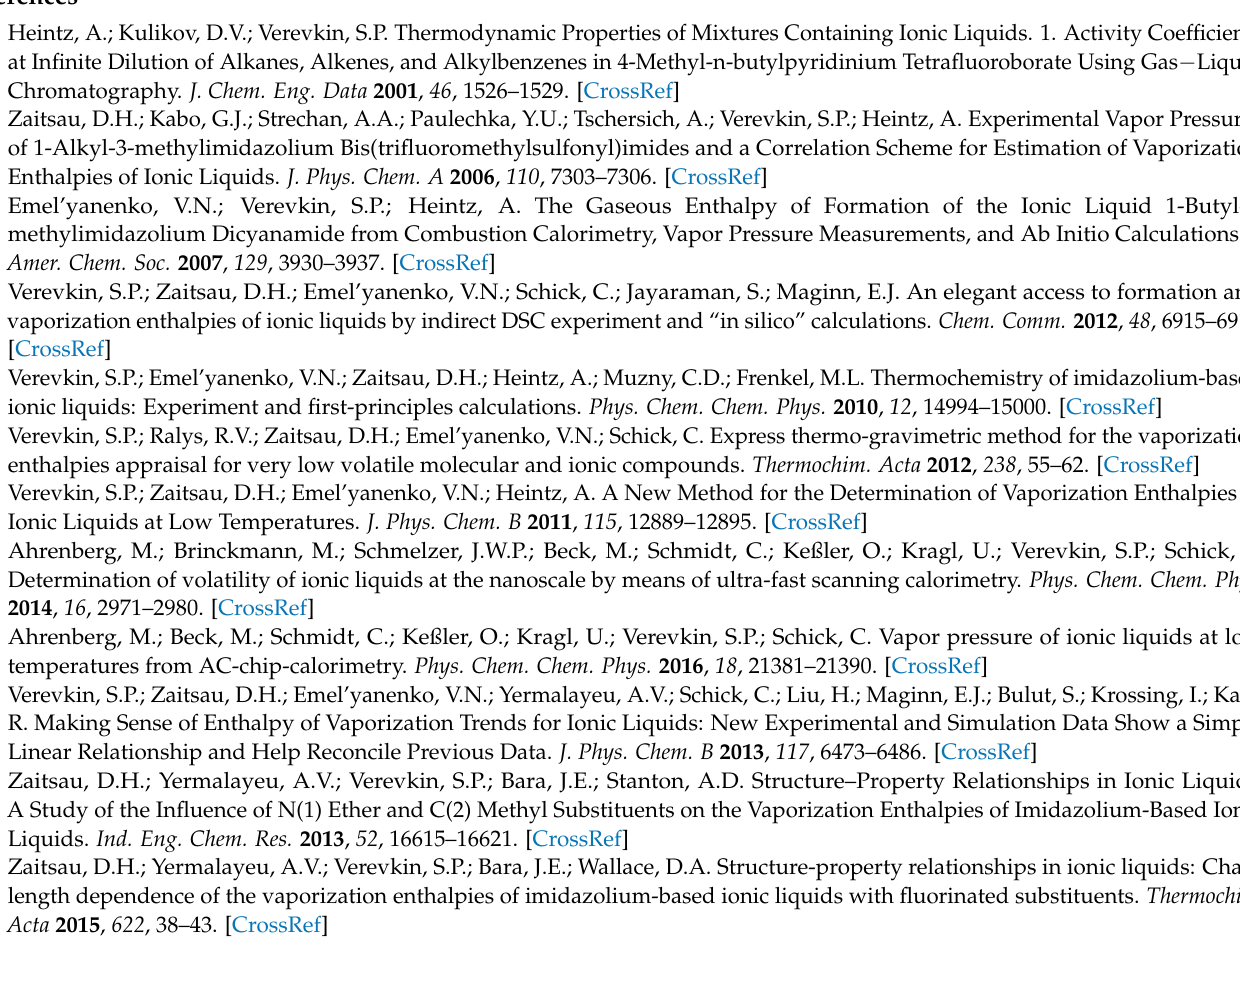
thalpies derived from activity coefficients with experimental results from conventional methods for [C n mim][NTf 2 ] series. Table S3: Comparison of vaporization enthalpies derived from activity coefficients with experimental results from conventional methods for [C n mim][NTf 2 ] series. Table S4: Comparison of vaporization en- thalpies derived from activity coefficients with experimental results from conventional methods for [C n mim][CF 3 CO 2 ] series. Table S5: Comparison of vaporization enthalpies derived from activity coefficients with experimental results from conventional methods for [C n mim][Anion] series with [CF 3 SO 3 ], [CH 3 SO 3 ], and [Cl] anions, Table S6: Comparison of vaporization enthalpies derived from activity coefficients with experimental results from conventional methods for [C n mim][Anion] series with fluorine containing anions, Table S7: Comparison of vaporization enthalpies derived from activity coefficients with experimental results from conventional methods for [C n mim][NO 3 ] series, Table S8: Comparison of vaporization enthalpies derived from activity coefficients with experimental results from conventional methods for [C n mim][Anion] series with cyano-containing anions. Funding: This research was funded by the German Science Foundation (DFG) in the frame of the priority program SPP 1807 “ Control of London Dispersion Interactions in Molecular Chemistry ” (grant VE 265/9-2), as well as of the priority program SPP 1708 “ Material Synthesis Near Room Temperature ” (grant VE